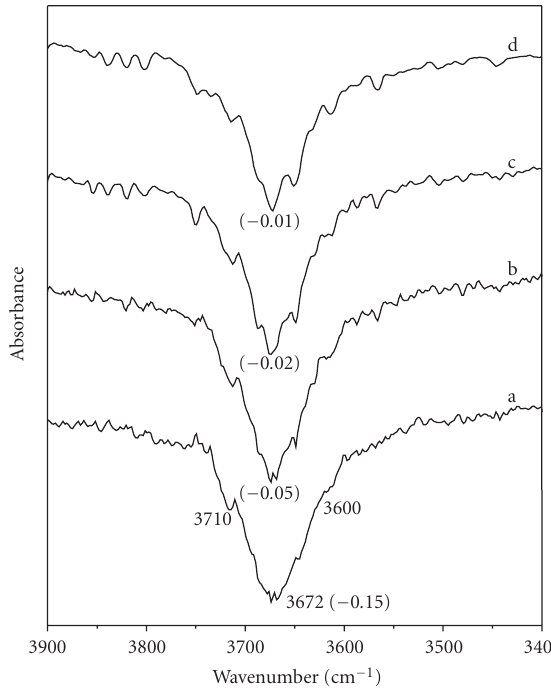
Figure 13: Hydroxyl region IR spectra of sample H3 after room temperature adsorption of 14 μ molg − 1 of acetone vapor and recorded after the lapse of 15 minutes (curve (a)) and subsequent heating at 320 K (curve (b)), 350 K (curve (c)), and 380K (curve (d)). The numbers given in the parentheses indicate the absorbance value of the particular IR